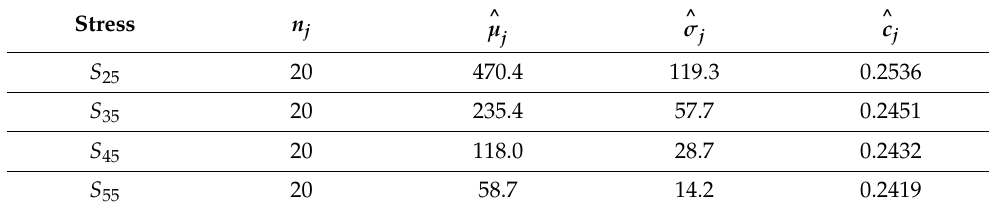
Table 5. The estimated means, standard deviations, and coefficients of variation of failure cycles for batteries at several stress